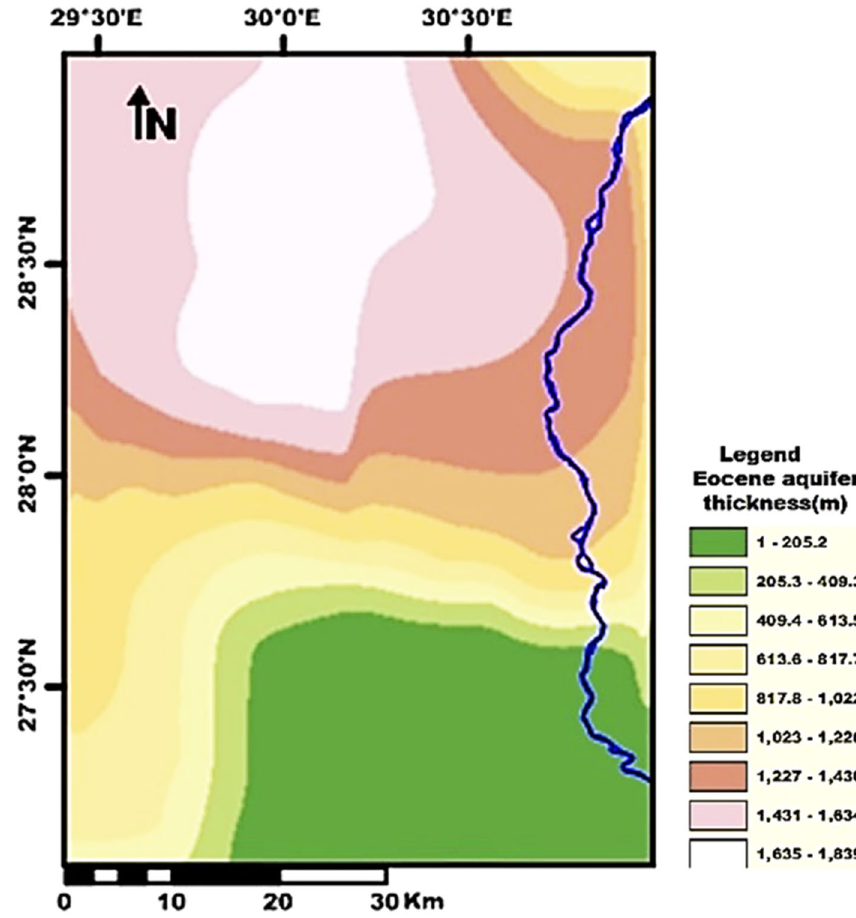
Fig. 7 The spatial